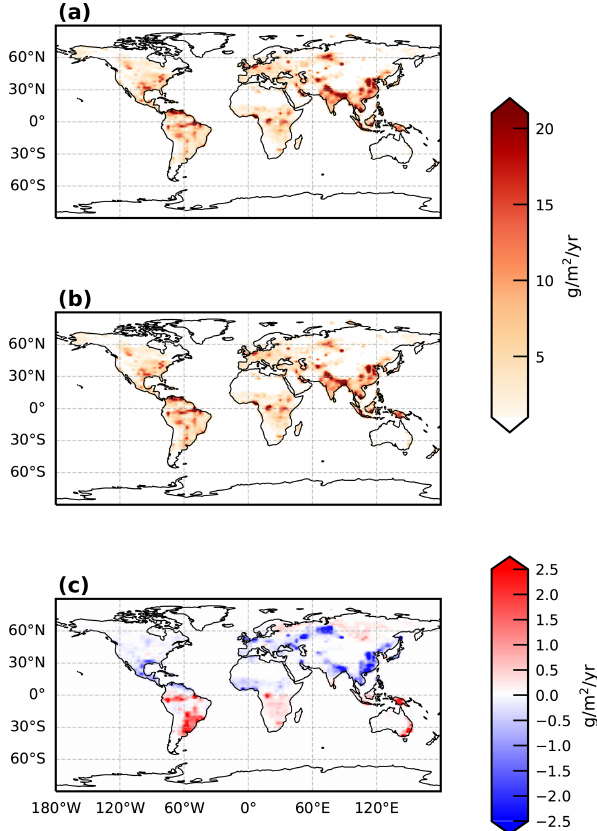
Figure A3. Global a posteriori emissions of methane (gm − 2 yr − 1 ) inferred from GOSAT methane:CO 2 column ratio data for the baseline year of 2019, corresponding to (a) OH climatology (Feng et al., 2022b) and (b) the joint methane–OH inversion. Panel (c) shows the difference of a posteriori emissions of methane corresponding to the joint methane–OH inversion minus OH